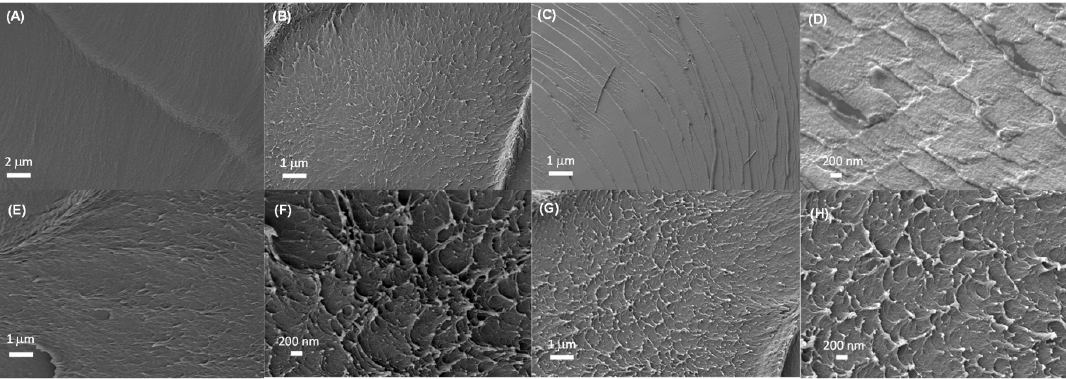
Figure 4. SEM images of cross-sections of PBI membranes after immersion in DIW ( A , B ), phosphoric acid 0.1 M ( C , D ), phytic acid 0.075 M ( E , F ), and HPW 0.1 M ( G , H ).